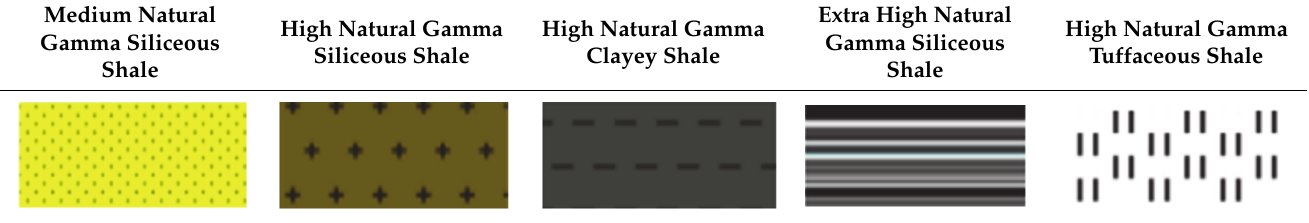
Figure 9. Results of lithology identi fi cation of well J3 in sample data well.